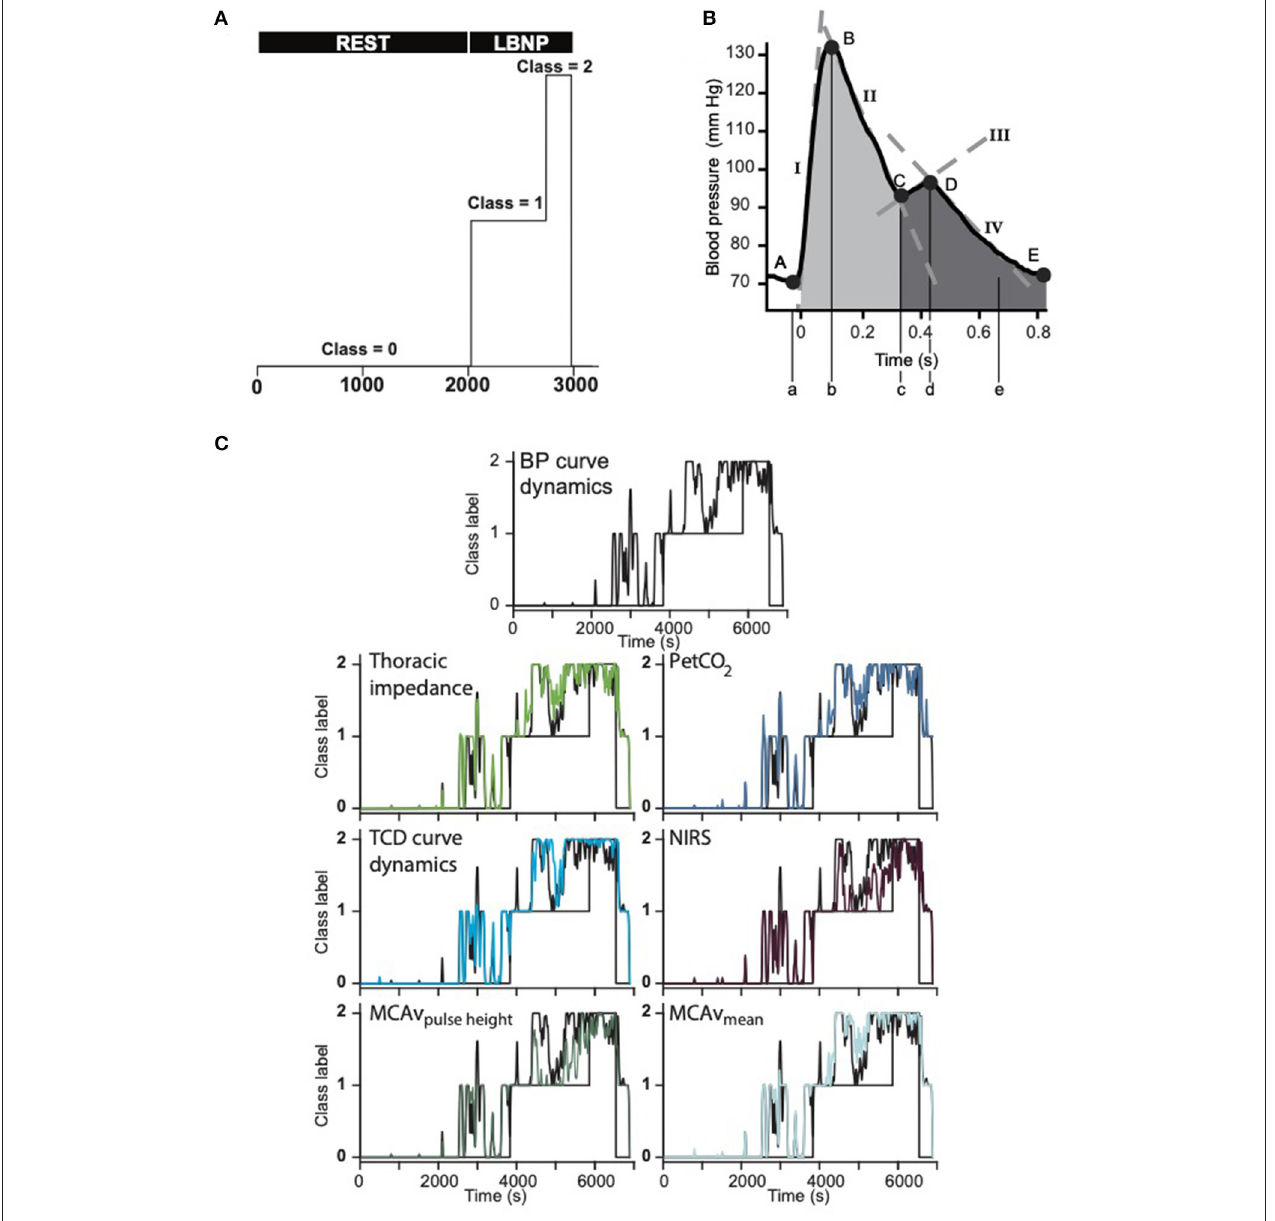
FIGURE 2 | (A) Class definitions: baseline rest—class 0. LBNP (50 mmHg) defined as class 1, of which the last 25% as end-stage LBNP before pre-syncope (class 2). LBNP, lower body “negative” or sub-atmospheric pressure. (B) Single arterial pressure curve with five primary points (A–E). From these points, model parameters were estimated. Their accompanying time points are described with lower case letters. Tangent lines are described with roman numerals. Areas of interest are shaded. (C) In 42 (27 female) healthy subjects CBV was progressively reduced by LBNP until the onset of pre-syncope. The figure represents the output of six models compared to the blood pressure curve dynamics model (#1, top) in a single subject. Each subsequent graph shows the modulation of the addition of the annotated feature(s). In this subject the model for MCAv pulse height (bottom left) had the lowest error. Note that all model outputs increase with increasing duration of lower body negative pressure. BP, blood pressure; PetCO2, end-tidal carbon dioxide partial pressure; NIRS, near infrared spectroscopy; TCD, transcranial Doppler; MCAv, middle cerebral artery blood flow velocity; LBNP, lower body “negative” or sub-atmospheric pressure. Modified from van der Ster et al. (2018a,b).